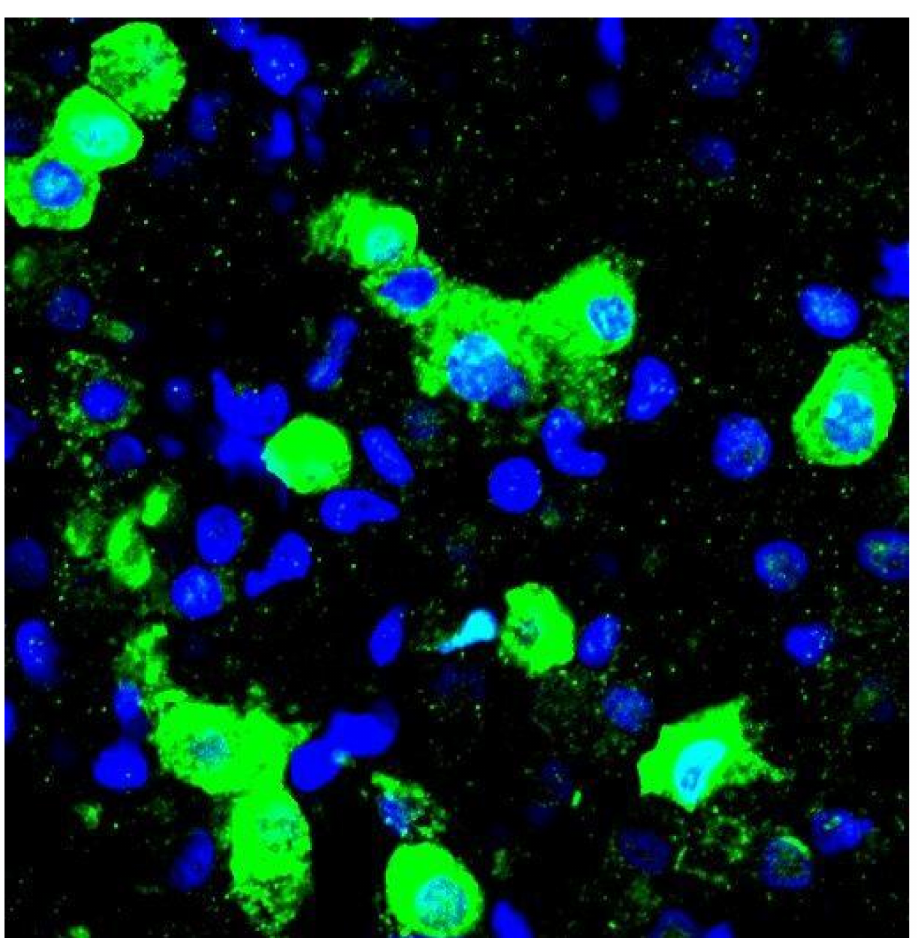
Figure 1. Morphology and protein expression of adult human alveolar type II (ATII) cells. Represen- tative image of immunofluorescence staining for isolated human alveolar type II cells, expanded in culture after 2 days. Alveolar type II cells (ATII) are small and have a cuboidal shape. ATII cells were isolated from five different patients. The cells were seeded after isolation in primary 96-well plates coated with collagen type II. Cell growth in PneumaCult medium enriched with 10% Fetal Bovine serum and 1% Penicillin/Streptomycin. The cells were washed the next day with Phosphate Buffered saline and fixed with Paraformaldehyde at 4% and stained for the specific ATII marker Surfactant Protein C (Pro-SPC) (shown in green). Cell nuclei were stained in blue using Hoechst staining. The image was acquired with a confocal microscope Zeiss LSM 880 with Aryscan. Scale bar 10 µ